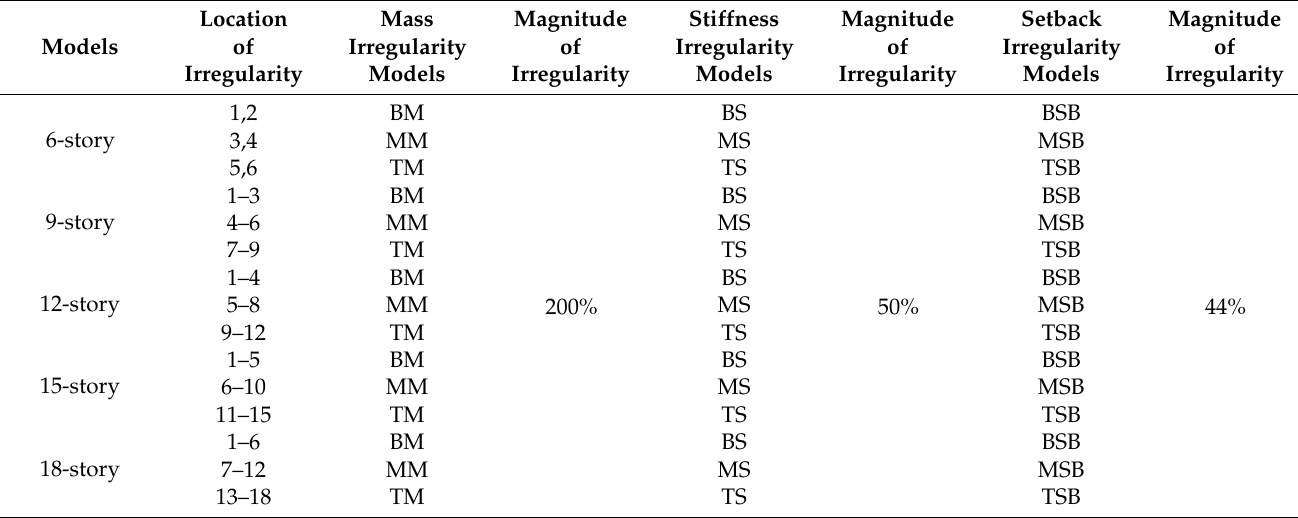
Table 4. Description of different irregularity